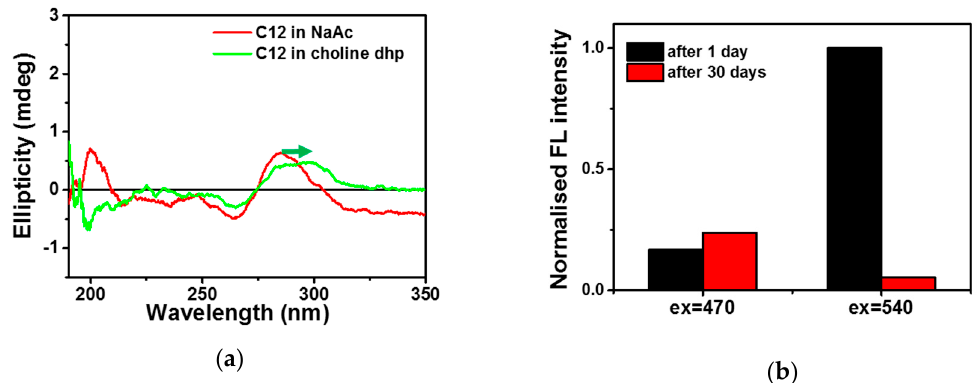
Figure 4. ( a ) The circular dichroism (CD) spectra of 2 μ M C12 in 3.0 M sodium acetate-acetic acid (NaAc-HAc) (pH 7.0) and 3.0 M choline dihydrogen phosphate (dhp)-NaOH (pH 7.0) at 25 ° C, respectively. ( b ) The normalised emission intensity of C12-templated Ag nanoclusters (NCs) excited at 470 nm (ex = 470) and 540 nm (ex = 540) in 1.0 M choline dhp buffer at 25 ° C measured at 1 day and 30 days after the synthesis.